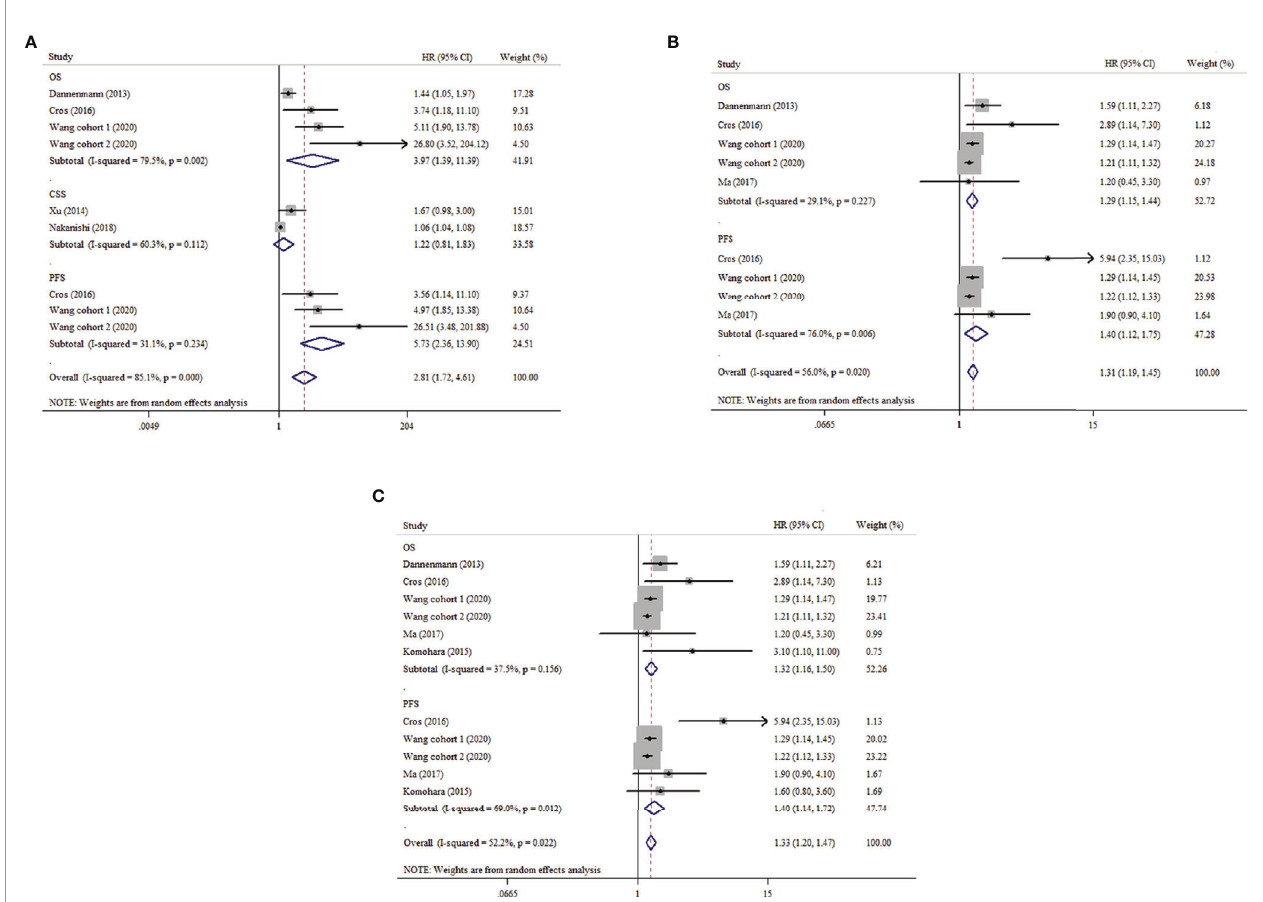
FIGURE 2 | Forest plots of HRs for prognostic value with high versus low density of TAMs in RCC patients. (A) HRs of OS, CSS and PFS for CD68+ TAMs in RCC; (B) HRs of OS and PFS for CD163+ TAMs in RCC; (C) HRs of OS and PFS for M2-TAMs in